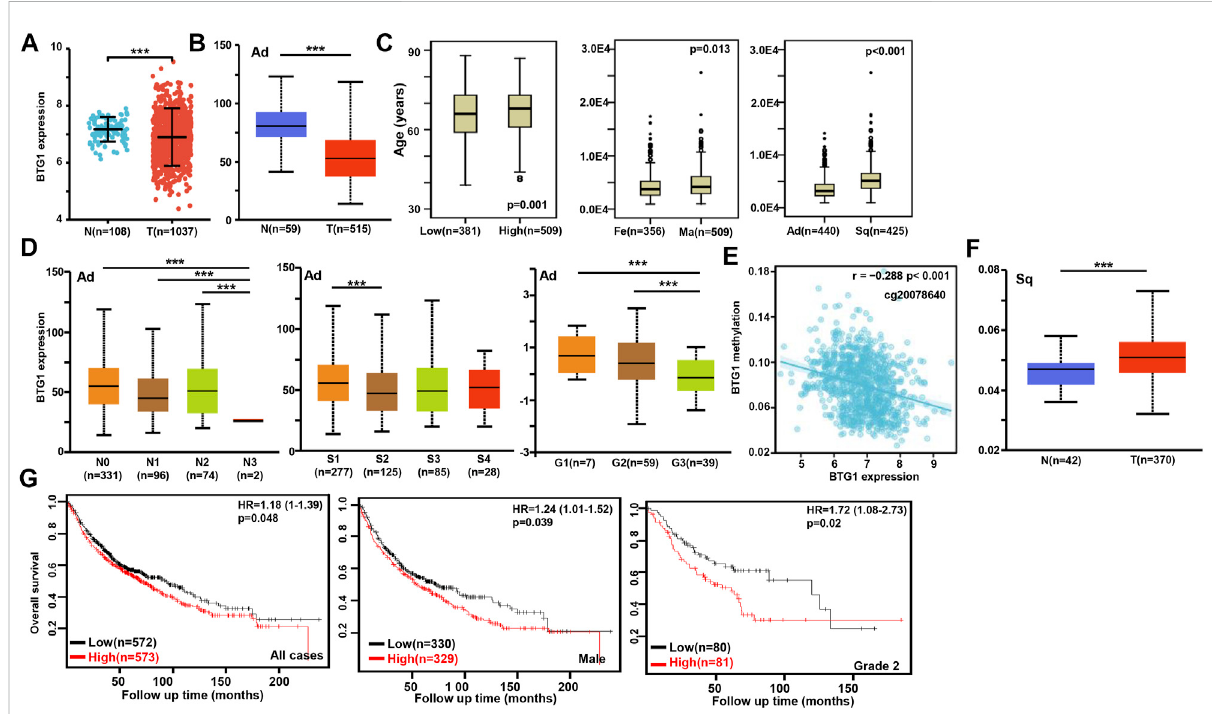
FIGURE 2 The clinicopathological and prognostic signi fi cances of BTG1 mRNA expression in lung cancer. Xiantao (A) and UALCAN (B) datasets were employed for bioinformatics analysis to analyze BTG1 expression during lung carcinogenesis. BTG1 expression was downregulated in lung cancer, compared withnormal tissue( p < 0.05). BTG1 expressionwascompared withage, genderandhistologicalsubtyping ofthecancer patientsbyTCGA (C) ,andwithNstaging,clinicopathologicalstagingandhistologicalgradingbyUALCAN (D) .Thenegativerelationshipbetween BTG1 expression andmethylationwasanalyzedinlungcancerusingxiantaodatabase (E) .ItsmethylationwashigherinlungcancerthannormaltissuesinUALCAN (F) . The correlation between BTG1 expression and overall or post-progression survival rate of the patients with lung cancer was analysis using Kaplan- Meier plotter (G) . Note: Ad, adenocarcinoma; Sq, squamous cell carcinoma; Fe, female; Ma, male; S, stage; HR, hazard